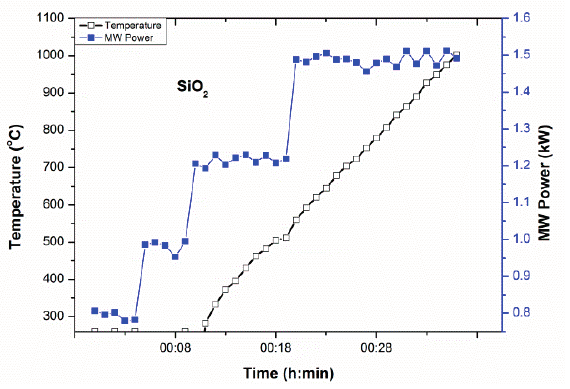
Figure 2. Temperature-microwave power-time (T-P-t) profile of SiO 2 . The temperature increase was noticed at 0.9 kW microwave power after 10 min with a manual increase of microwave power from 0.8